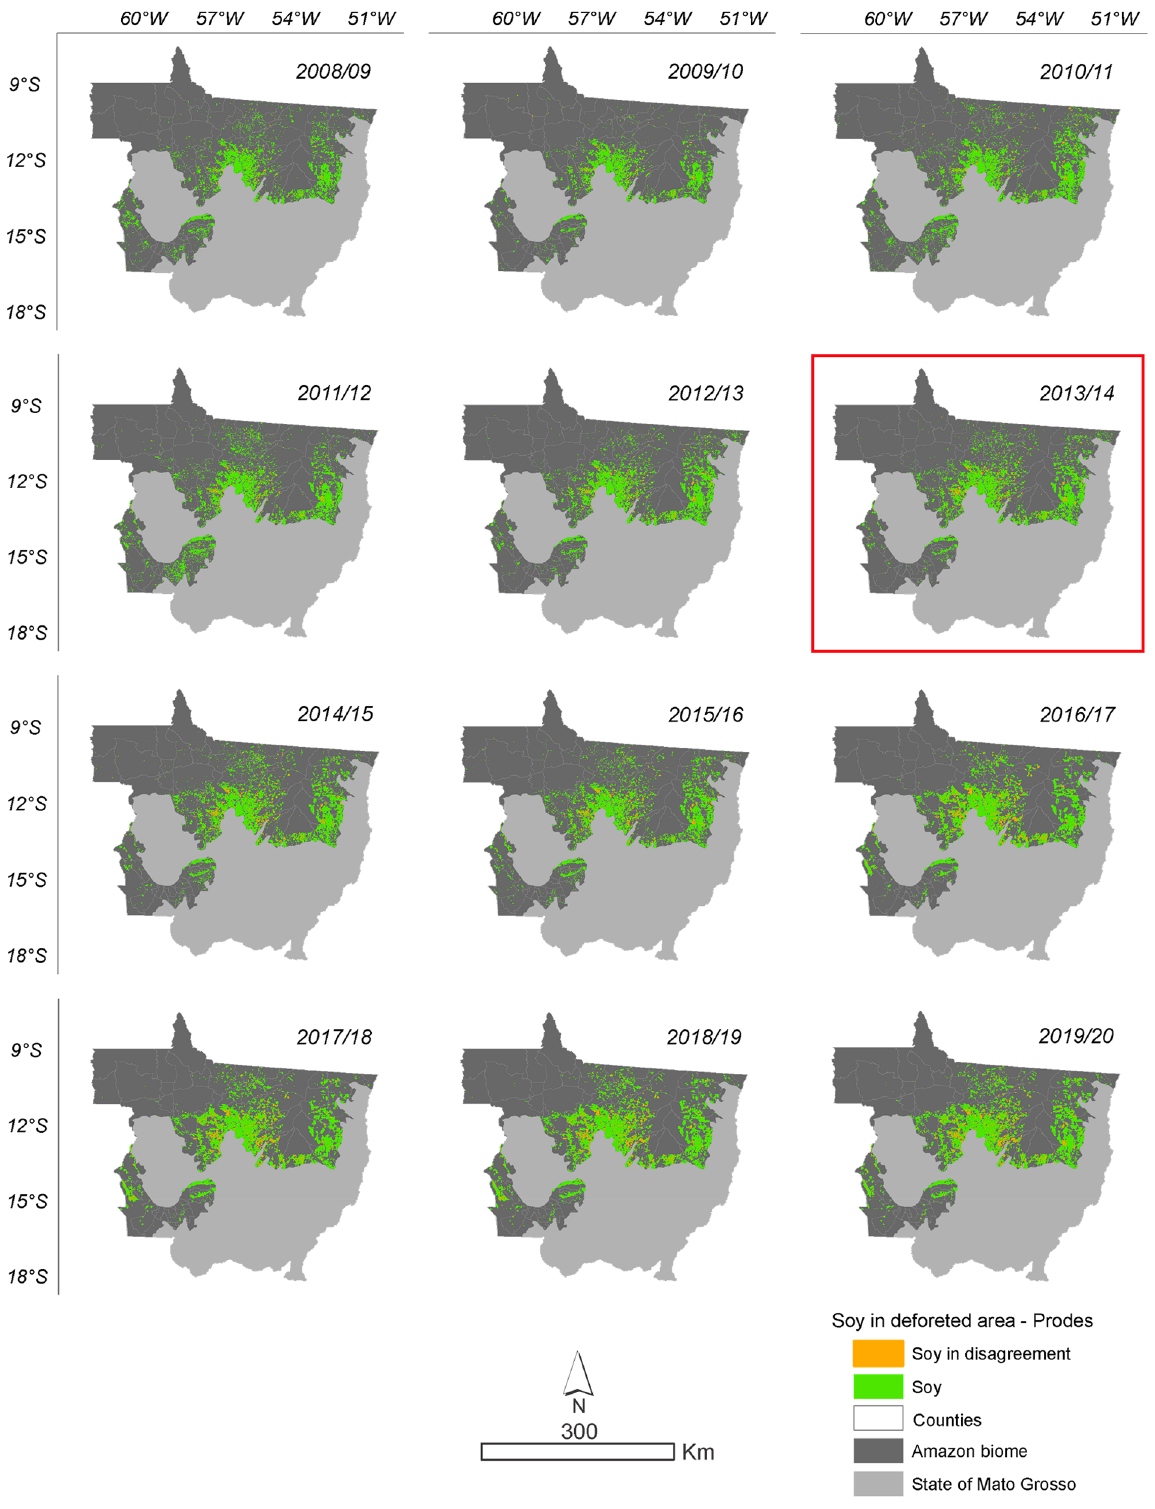
Figure 5. Soybean planted in the deforested area according to PRODES deforestation data. The highlighted year corresponds to the likely change point in the time series identified by the Pettitt test (Table